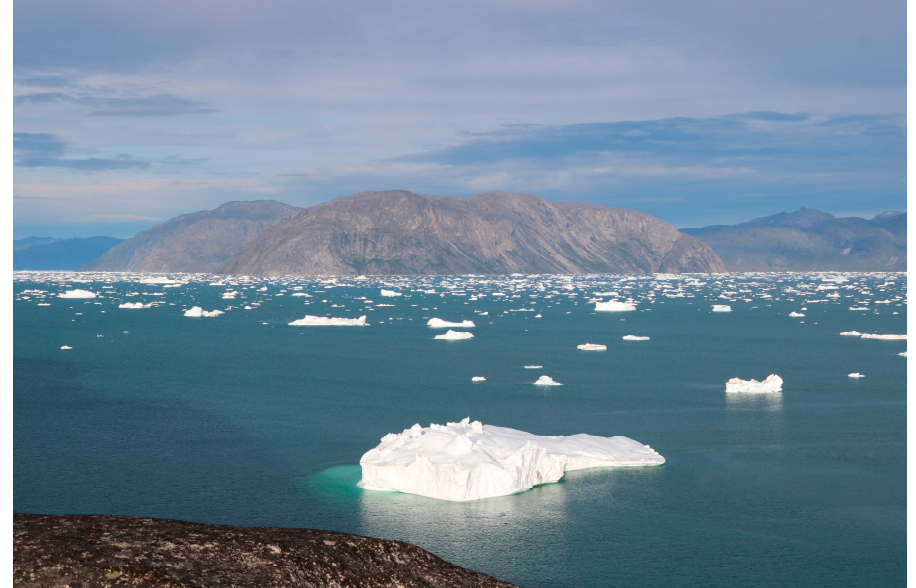
Figure 9. Image from a camera station placed in the bottom of the fjord Nuup Kangerlua. Photo taken on 13th of August 2018.